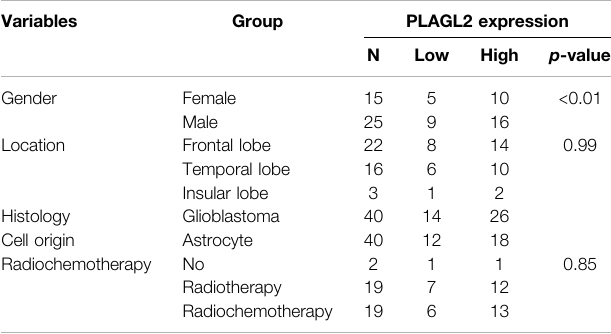
TABLE 2 | Association of PLAGL2 expression in GBM tissues with different clinicopathological features.